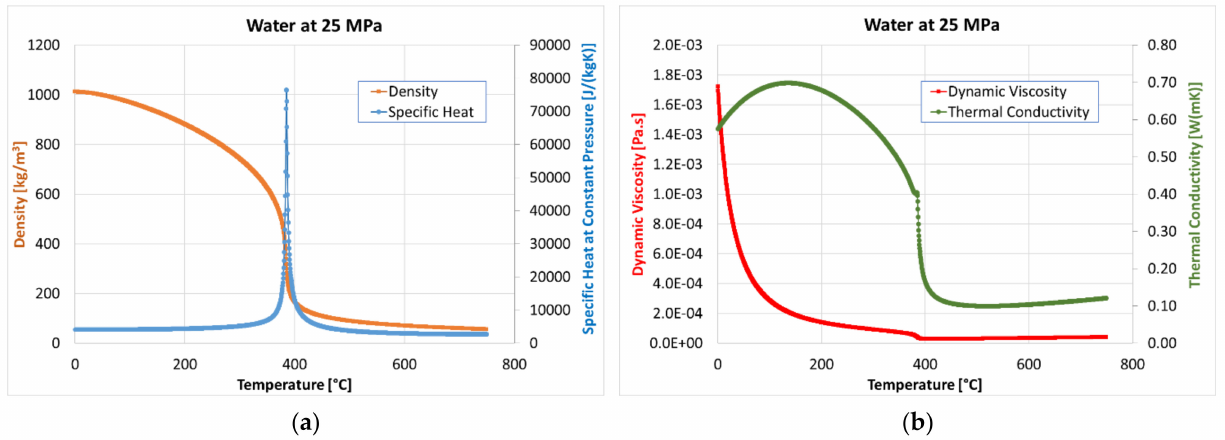
Figure 1. Thermodynamic ( a ) and transport properties ( b ) for water at 25 MPa.